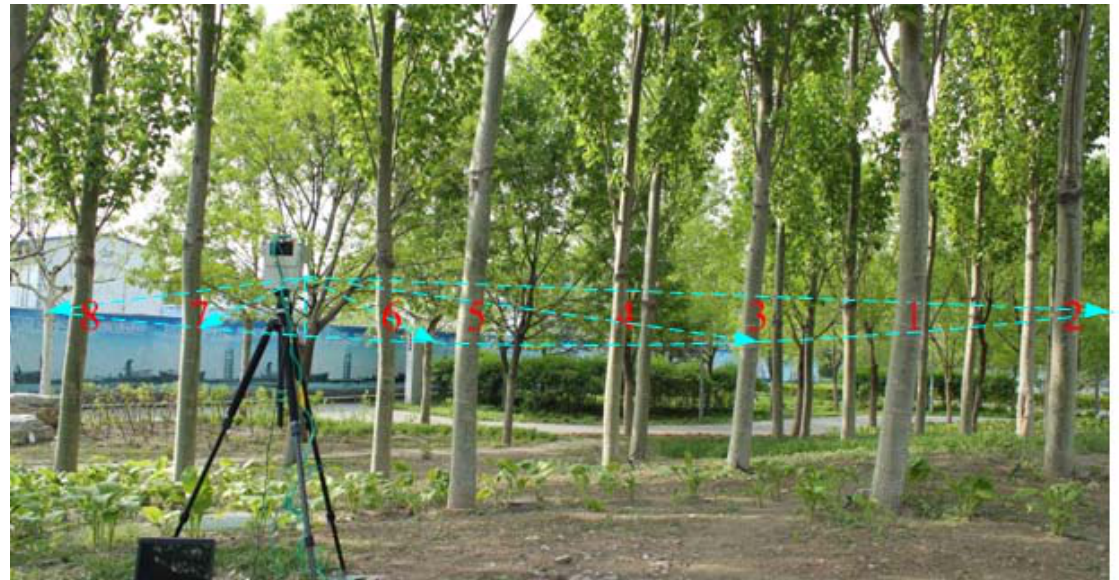
Figure 3. The experiment in the aspen